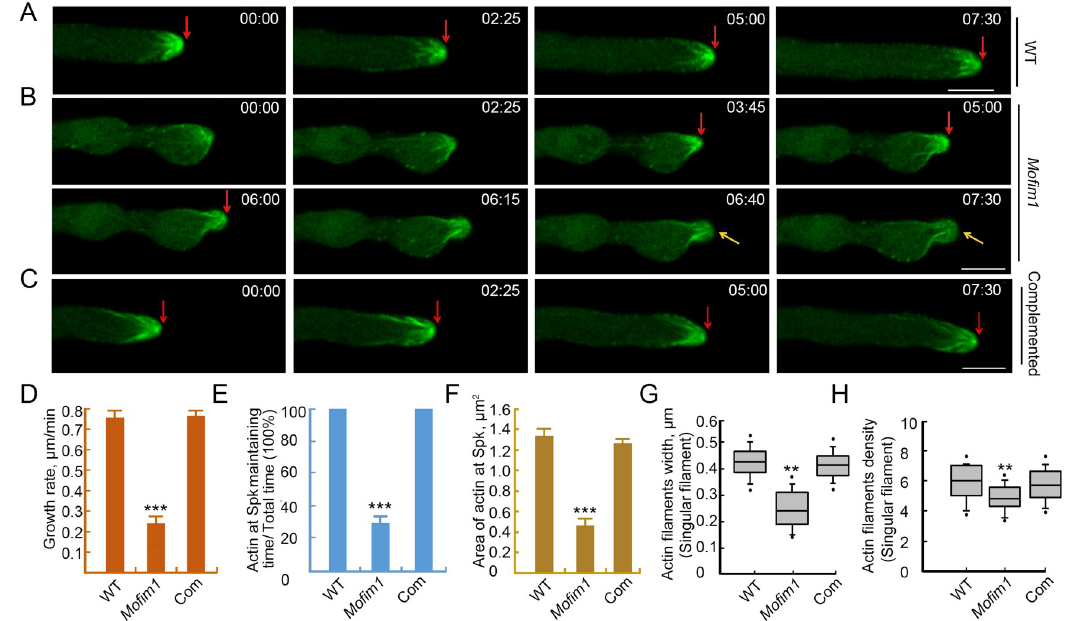
Fig 3. Defects of the Mofim1 mutant impaired in actin organization in the hyphal tip during polar tip growth. (A–C) Time- lapse images showing actin dynamics in growing WT (A) , Mofim1 mutant (B) , and the complemented (C) hyphae. The corresponding movie is provided as S4 Movie. The red arrows indicate the presence of actin at the Spk during polar growth. The yellow arrows in (B) indicate the absence of this structure. The numbers at the top right corner indicate the timestamps (min:s). Bar = 2 μ m. (D–G) Quantitative analysis of the growth rate (D) , maintaining time of actin at Spk (E) , area of actin at Spk (F) , width of actin cables (G) , and actin density (H) in WT, Mofim1 and the complemented strain (100 hyphae each of the WT, Mofim1 , and the complemented strain in three experimental repeats). Data are means ± SE ( n = 100); asterisks indicate statistically significant differences, as determined by Student’s t -test ( ��� , P < 0.001).